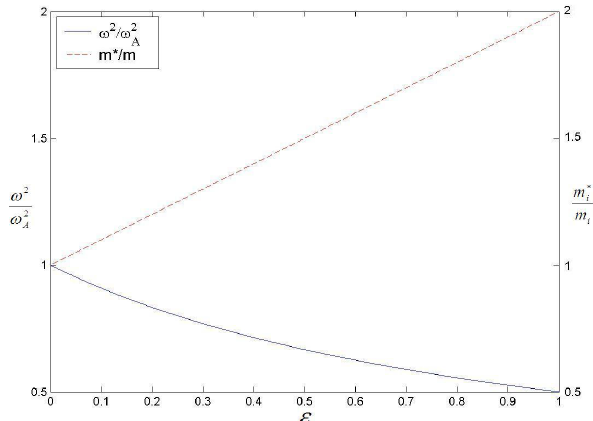
Fig.2 Influence of neutral dynamics on Alfvén wave based on Eq. (20) for ν ne tends to zero, non resistive medium and strong coupling. Also add Fig. 2. Influence of neutral dynamics on Alfv´en waves based on on mass effect (m* i ) on field line, due to strong coupling, is shown by dash line. Eq. (15) for V ne tending to zero, non-resistive medium and strong coupling. Also, add-on mass effect ( m ∗ i ) on field line, due to strong coupling, is shown by dashed